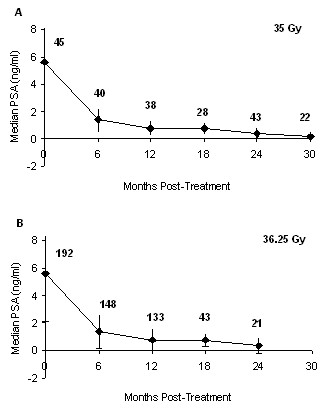
Median PSA levels (ng/ml +/- 1 standard deviation) for patients who did not receive ADT and who have a minimum follow-up of 12 month in the (A) 35 Gy dose level and (B) 36.25 Gy dose level.